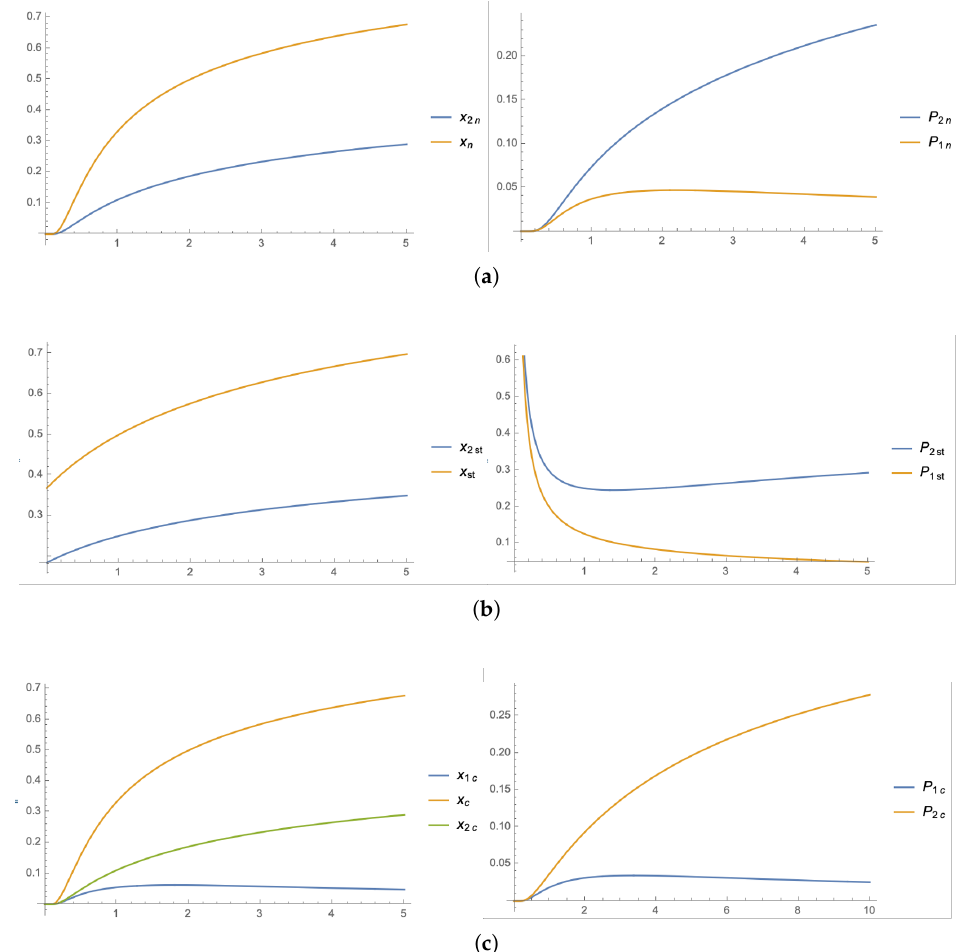
Figure A1. Left panels present the locations and right panels present the variable part of the prices (i.e., P ix − c ). ( a ) Nash competition; ( b ) Stackelberg competition; ( c ) Cournot